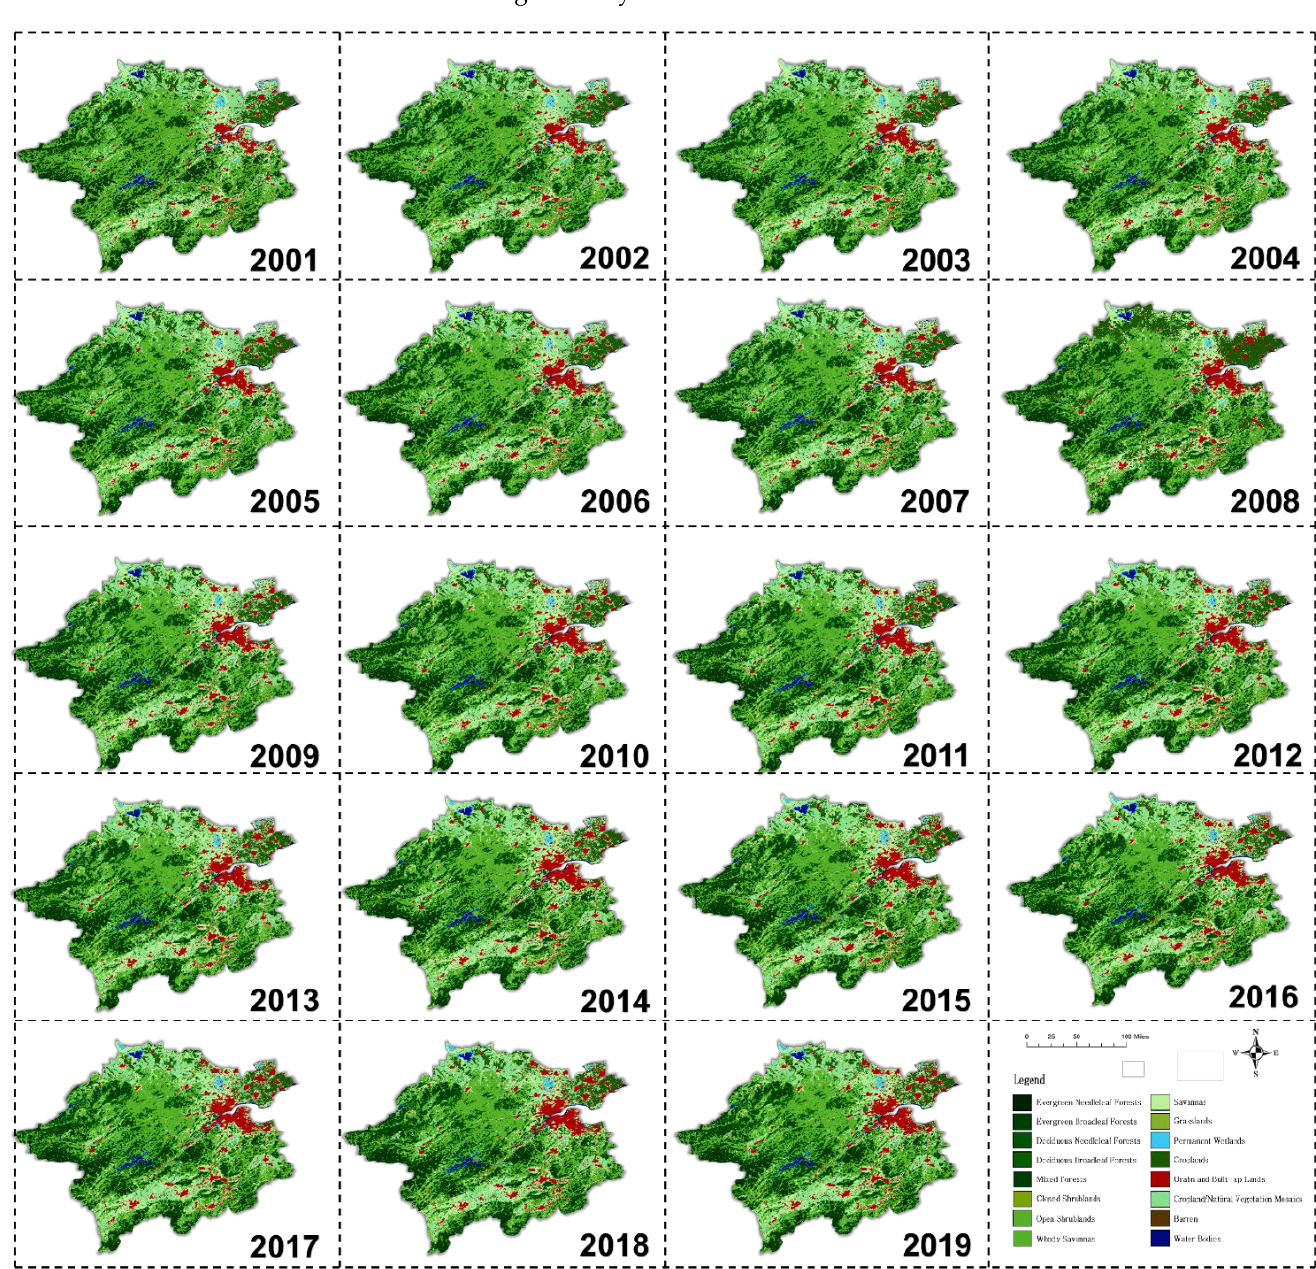
Figure 4. The main land-cover types in the study area from 2001 to 2019.